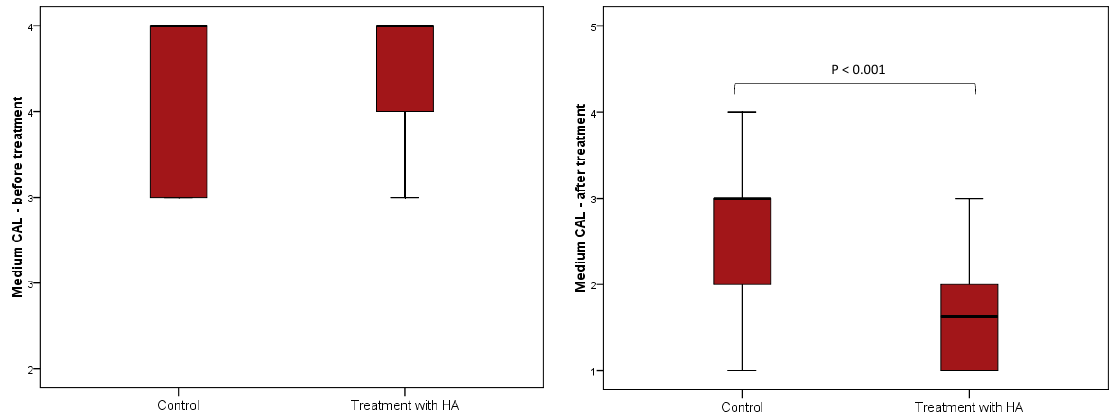
Figure A2. CAL values before ( left ) and after ( right ) treatment in the groups.